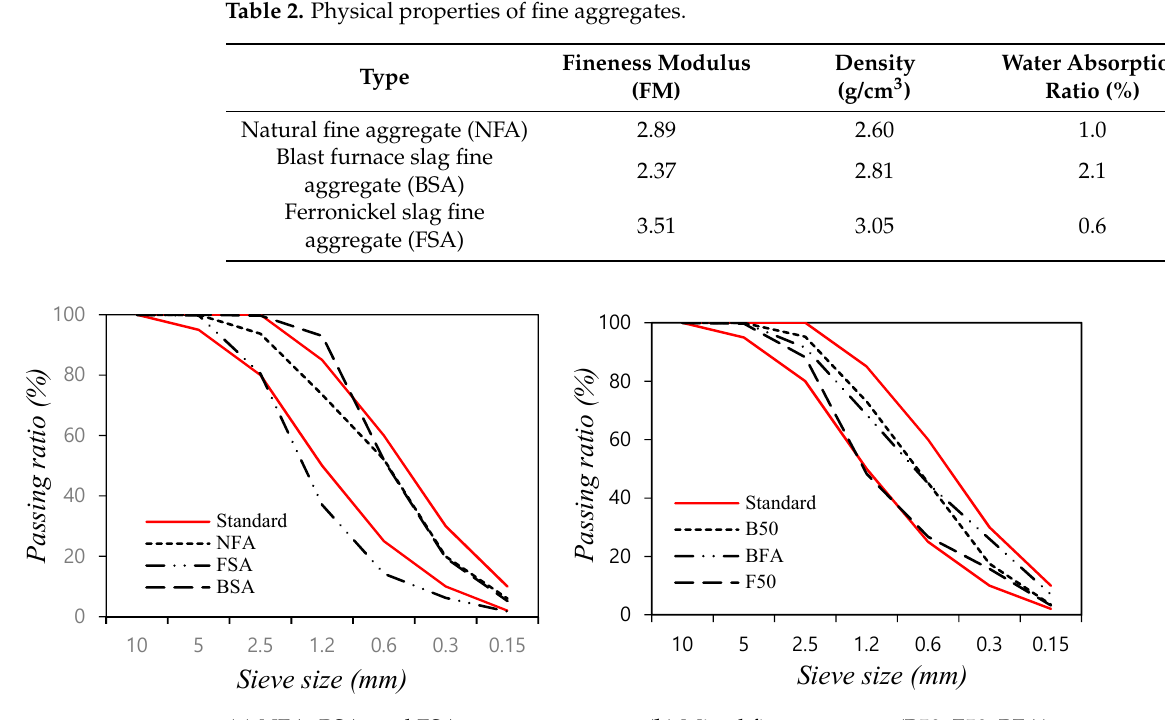
Figure 2. Particle size distribution of fine aggregates used in this study: ( a ) NFA, BSA, and FSA; ( b ) mixed fine